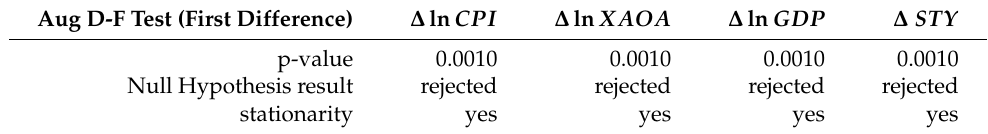
Table A5. ADF Unit Root Test at First